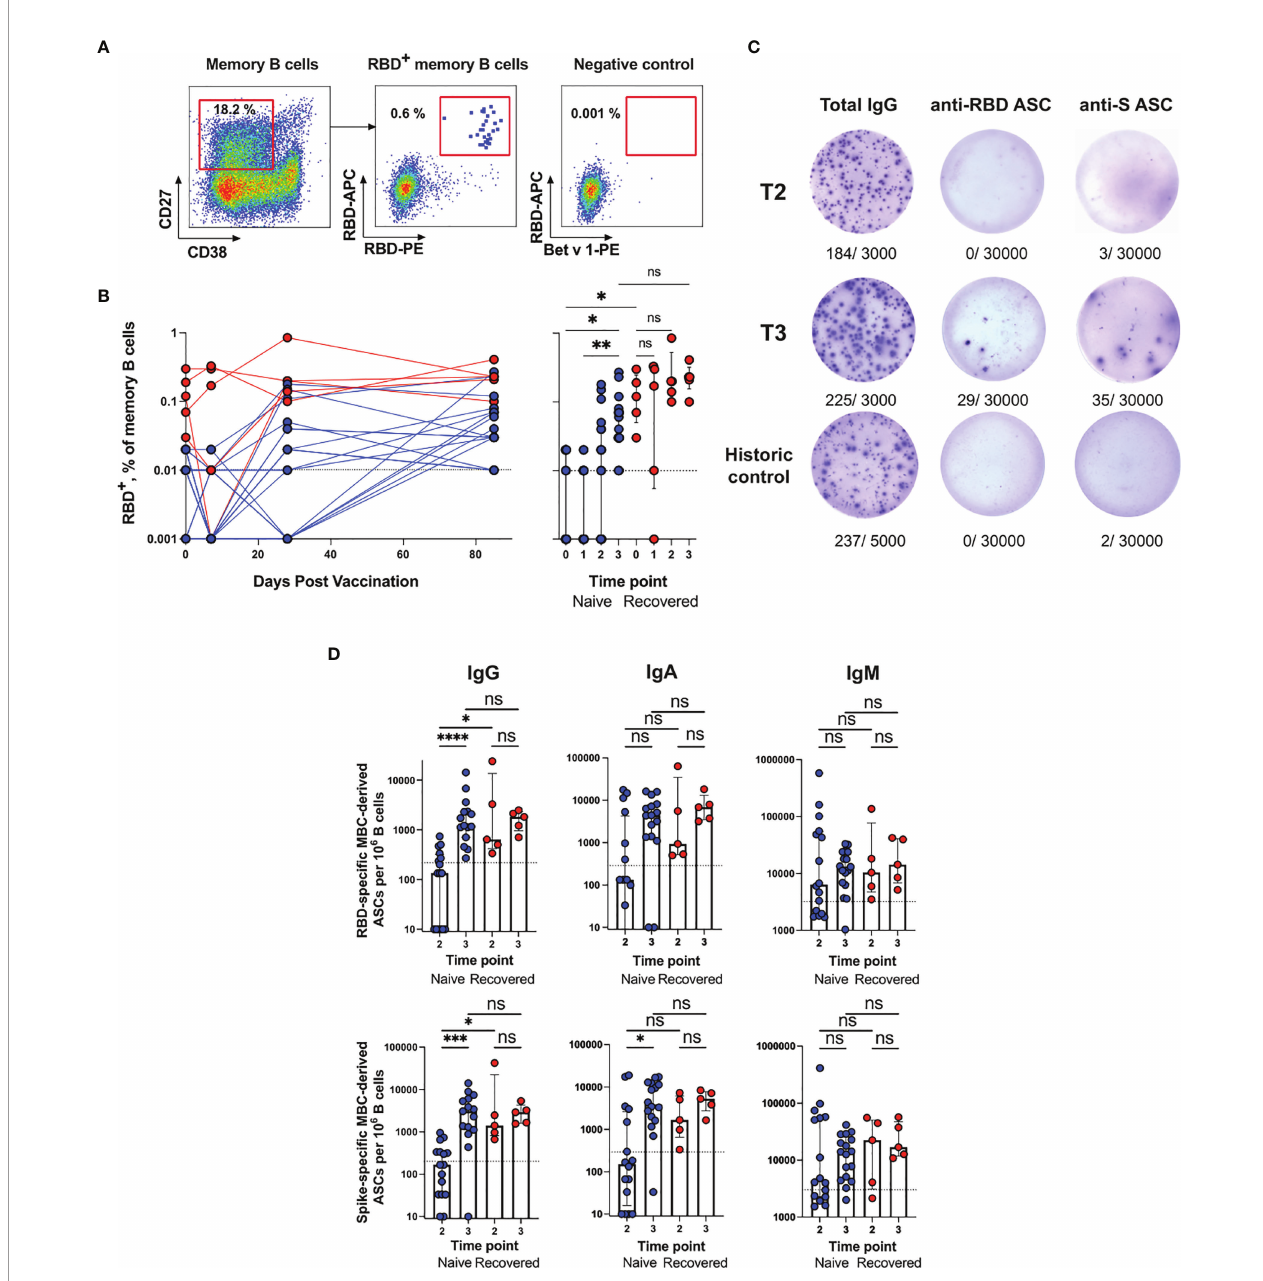
FIGURE 3 | Analysis of the MBC response in Sputnik V-vaccinated individuals. (A) Representative fl ow cytometry dot plots showing double discrimination of RBD + MBCs. Numbers inside the plots indicate the percentage of events speci fi c to the respective gates. (B) RBD + MBCs as a percentage of all memory B cells (CD19 + CD27 + CD38 - IgD - ). (C) Representative ELISpot showing SARS-CoV-2-speci fi c MBC-derived ASCs. Puri fi ed B cells were stimulated with IL-21/CD40L for 7 days and then incubated in ELISpot plates for 16 h to detect ASCs secreting total (left column), RBD-(middle column) or S-speci fi c (right column) IgG at T2 time point (upper row), T3 (middle row) or in historic control samples (bottom row). The numbers indicated below the wells represent positive dots and the total number of cells in the well. (D) RBD- (upper row) and S-speci fi c (bottom row) MBC-derived ASCs per 10 6 B cells from blood samples of naïve (n = 17) or recovered (n = 5) vaccinated individuals at different time points. Data for IgG (left column), IgM (middle column) and IgA (right column) ASCs are presented. The dotted lines indicate the threshold for a positive antigen-speci fi c ASC response calculated with pre-pandemic samples per 10 6 B cells. Results are shown for individual samples (symbols) from naïve (n = 17) and recovered (n = 5) recipients. Data are presented as median ± IQR. Asterisks indicate signi fi cant difference between groups determined using the Kruskal – Wallis test, *P < 0.05, **P < 0.01, ***P < 0.001, ****P < 0.0001, ns, not signi fi cant. ASC, antibody-secreting cell; IQR, interquartile range; RBD, receptor- binding